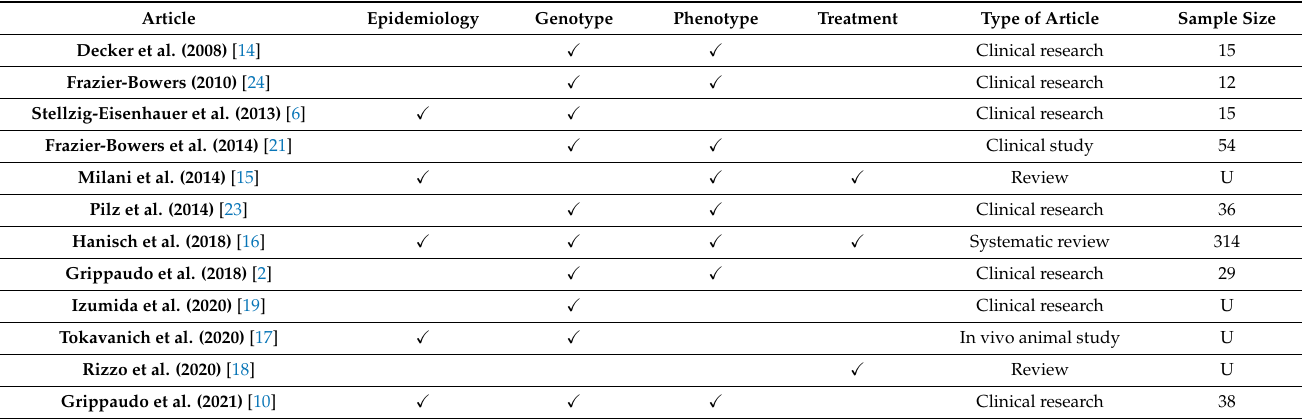
sample size. (Letter U =